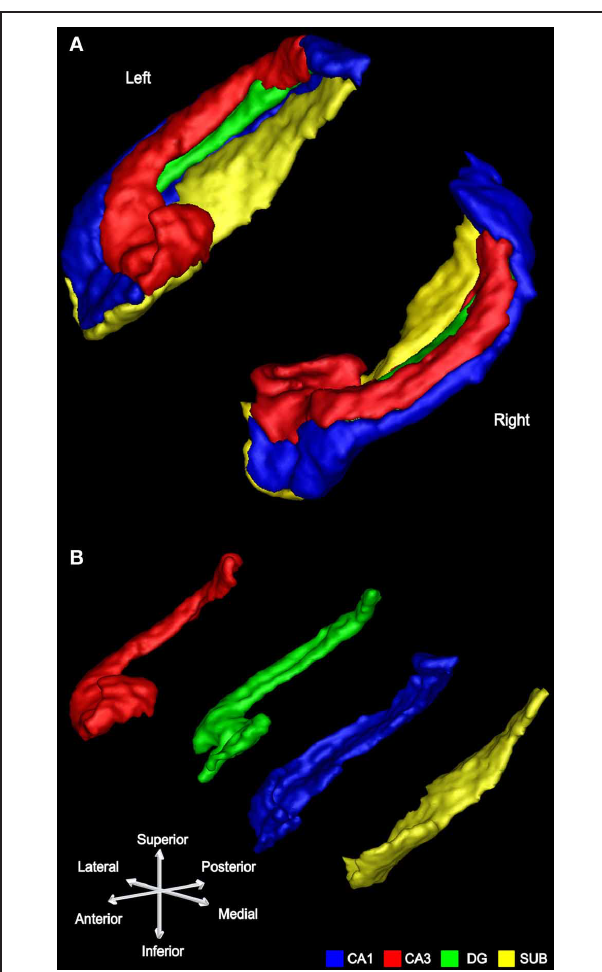
FIGURE 5 | An example of subfield segmentation in 3D. (A) The left and right hippocampus of a participant shown in 3D with the subfields conjoined. (B) The same left hippocampus is shown with its subfields separated. FIGURE 6 | Behavioural data. Means ± 1 SE are shown. (A) The